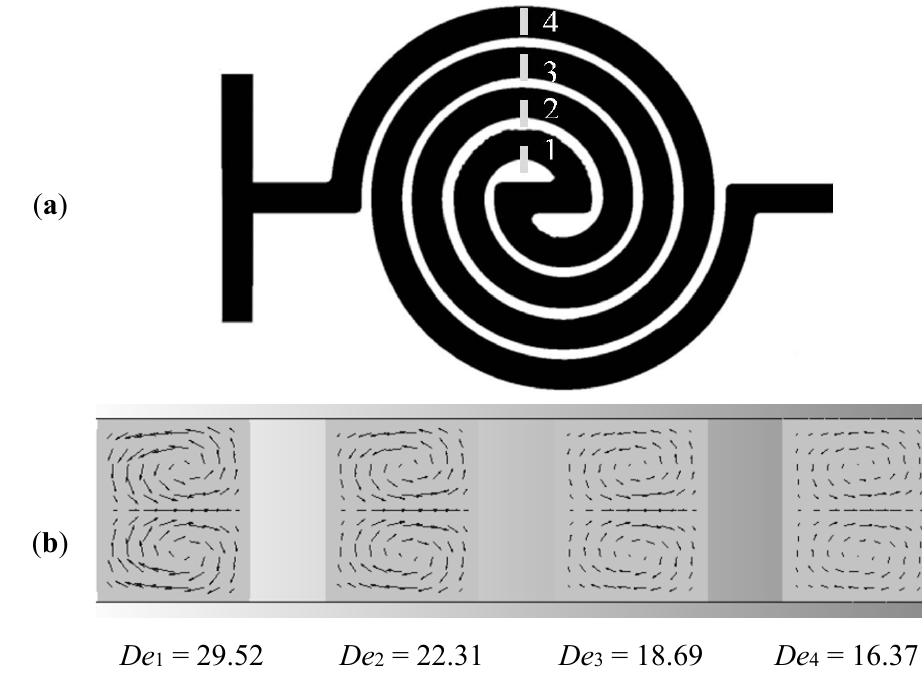
Figure 2. ( a ) Two-dimensional schematic of the spiral micromixer and ( b ) plots of generated counter rotating Dean vortices vectors at Re = 50 for cross sections 1, 2, 3, and 4 (The longer the arrows, the stronger the vortex rotational